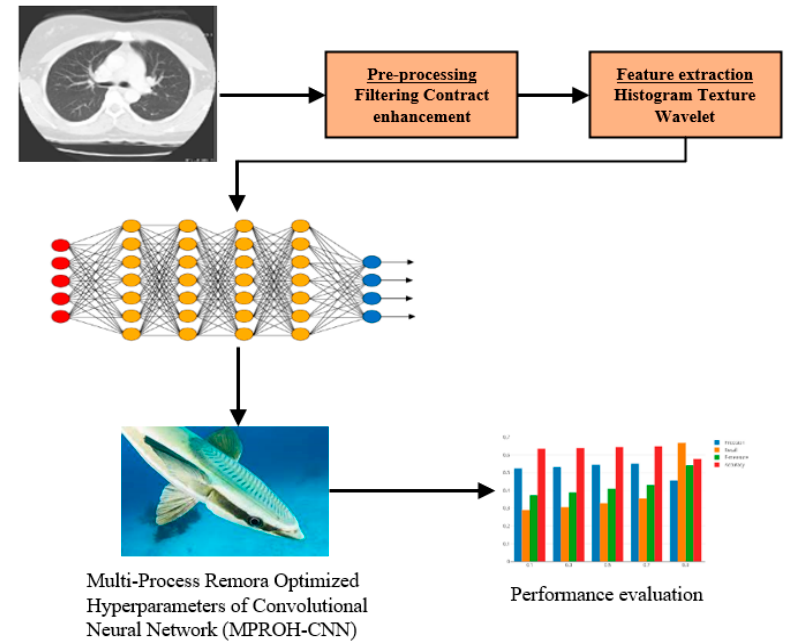
Figure 1. Design of the proposed methodology.